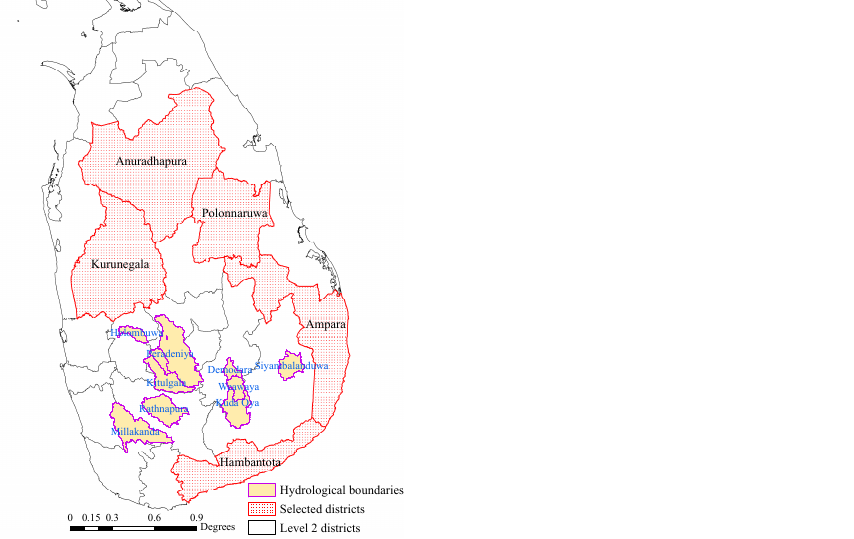
Figure 4. Location of the selected five districts (red boundaries) used for crop yield-based evaluation of the agCDI. In addition, the locations and extents of the hydrological boundaries (yellow background) are shown and labeled using the names of the river gauging stations.